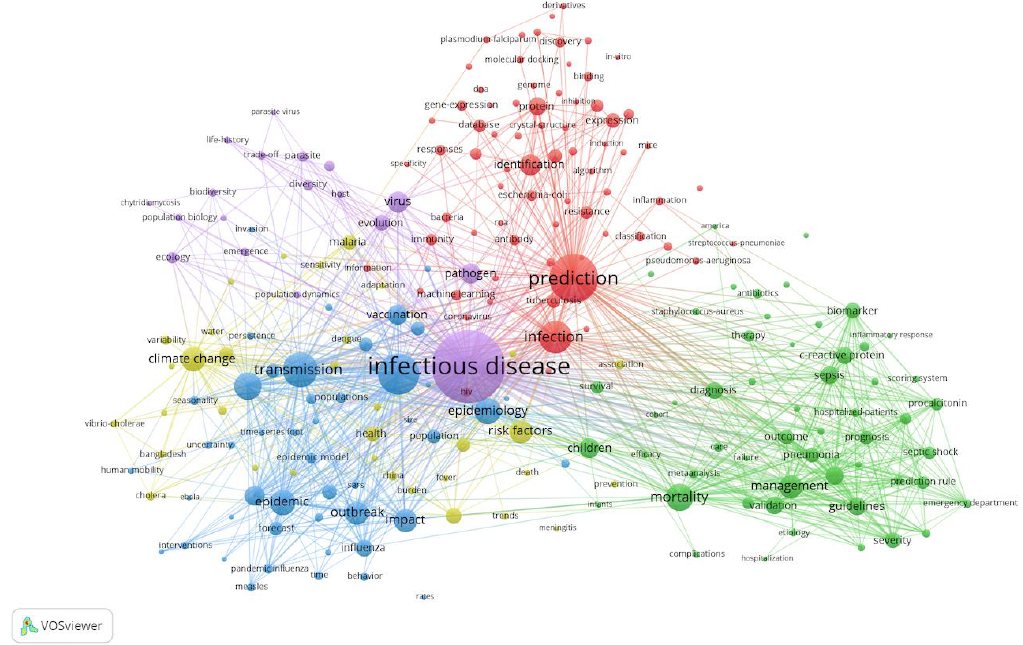
Figure 7. Keyword co-occurrence network about the field of the prediction of infectious diseases. Table 4. The top 20 keywords about the field of the prediction of infectious diseases.